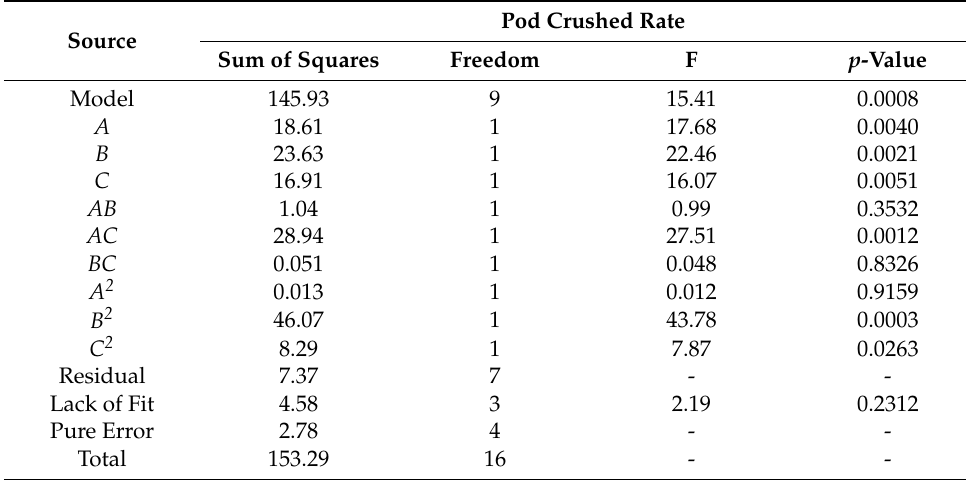
Table 6. Pod crushed rate analysis of variance.